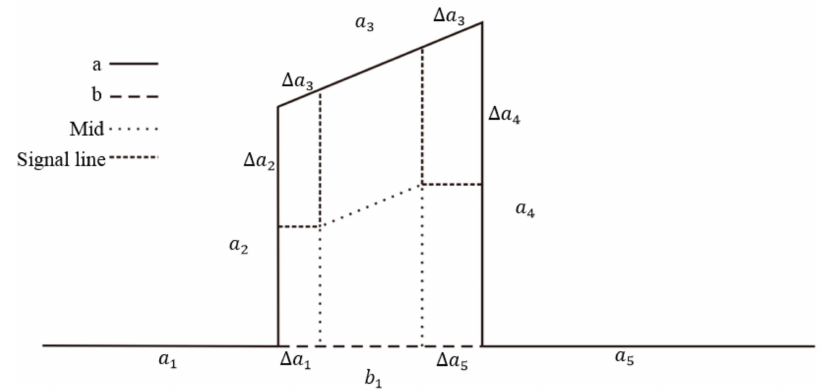
Figure 6. Interpolation of the intermediate scale based on the turning angle function-based morphing model